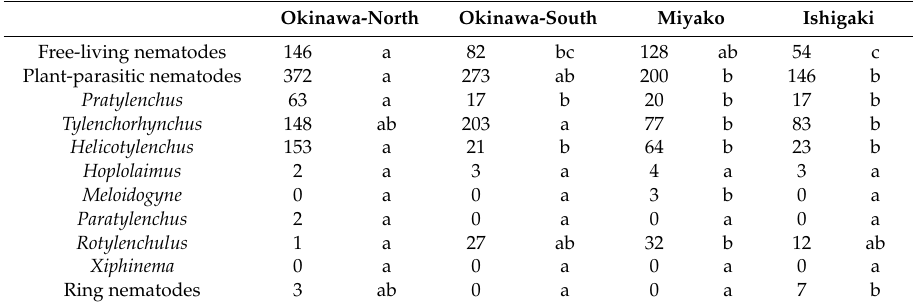
Table 1. Nematodes per 20 g